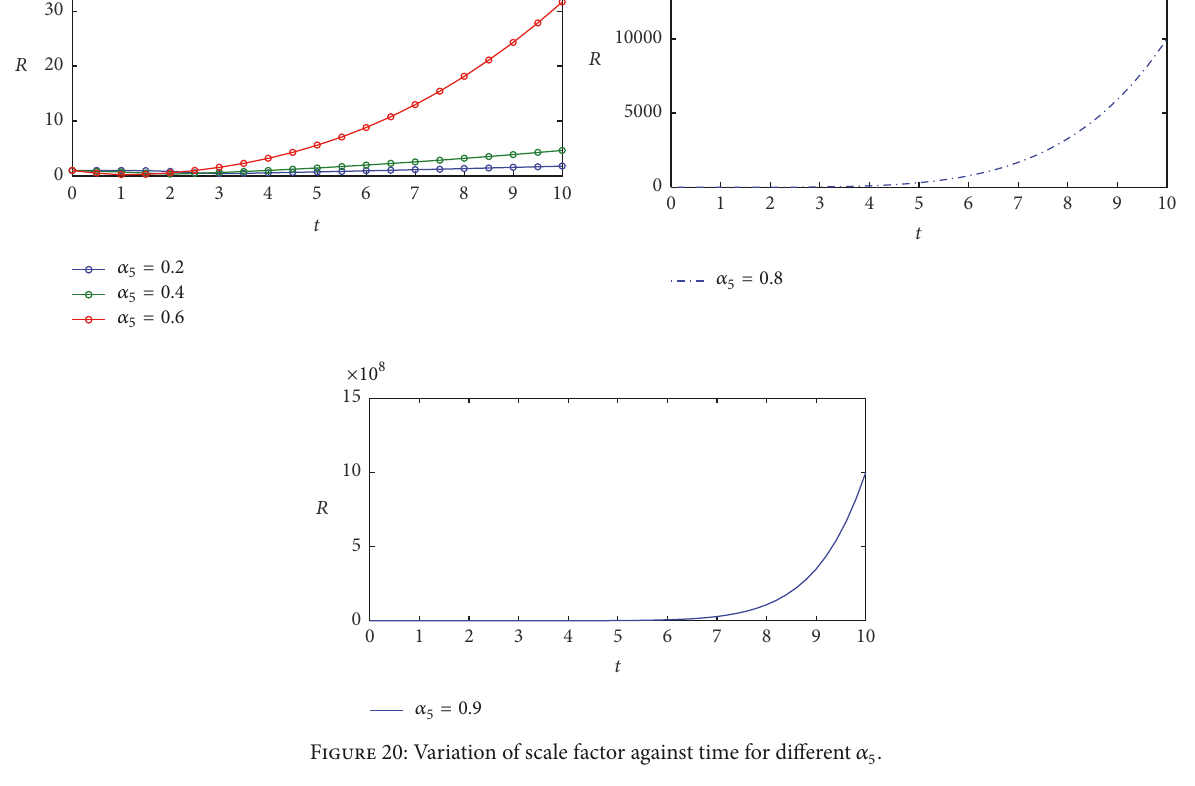
Figure 20: Variation of scale factor against time for different 𝛼 5 .